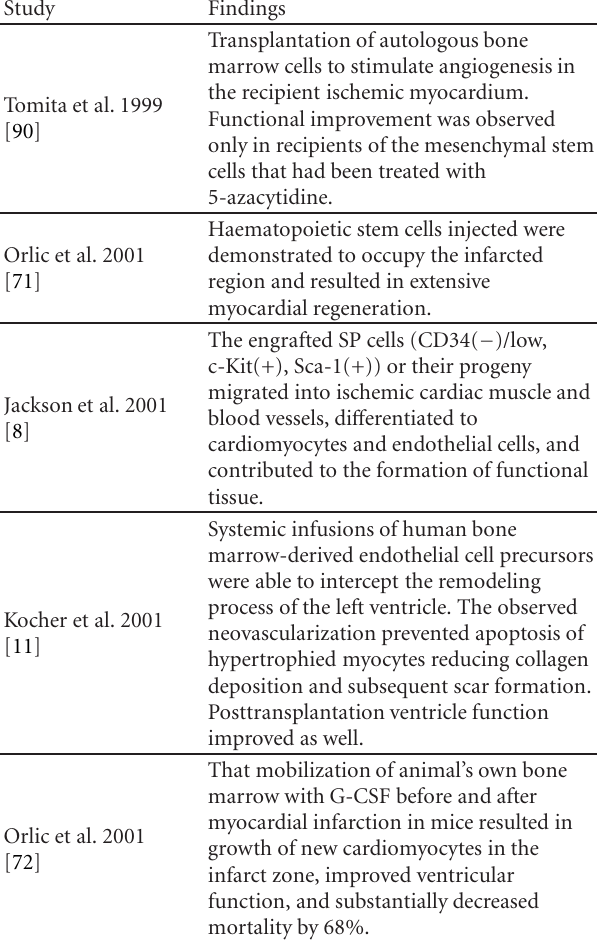
Table 3: Animal experiments demonstrating myocardial genera- tion with